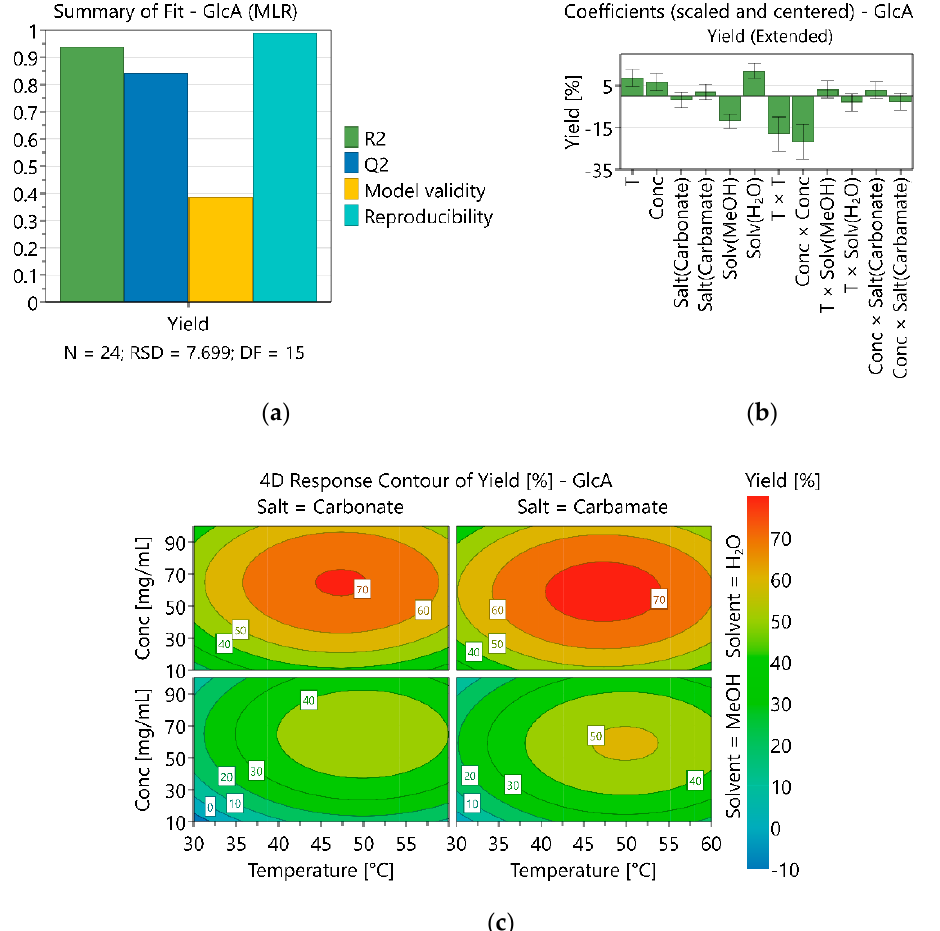
Figure 4. Plots of the model for GlcA generated by MODDE: ( a ) Summary of fit represents a good model; ( b ) plot of coefficient values for scaled and centered factors show significant factors according to the model; ( c ) the 4D response contour plot of yield predicts yields of amination in dependence on qualitative and quantitative